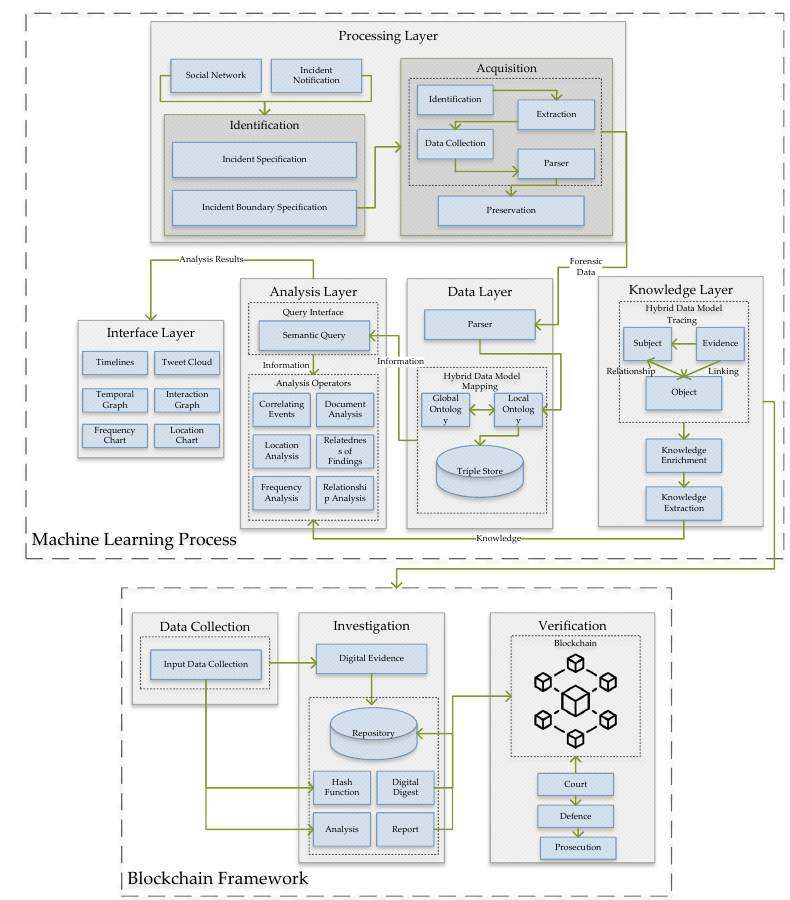
Figure 1. Overview of the proposed digital forensic